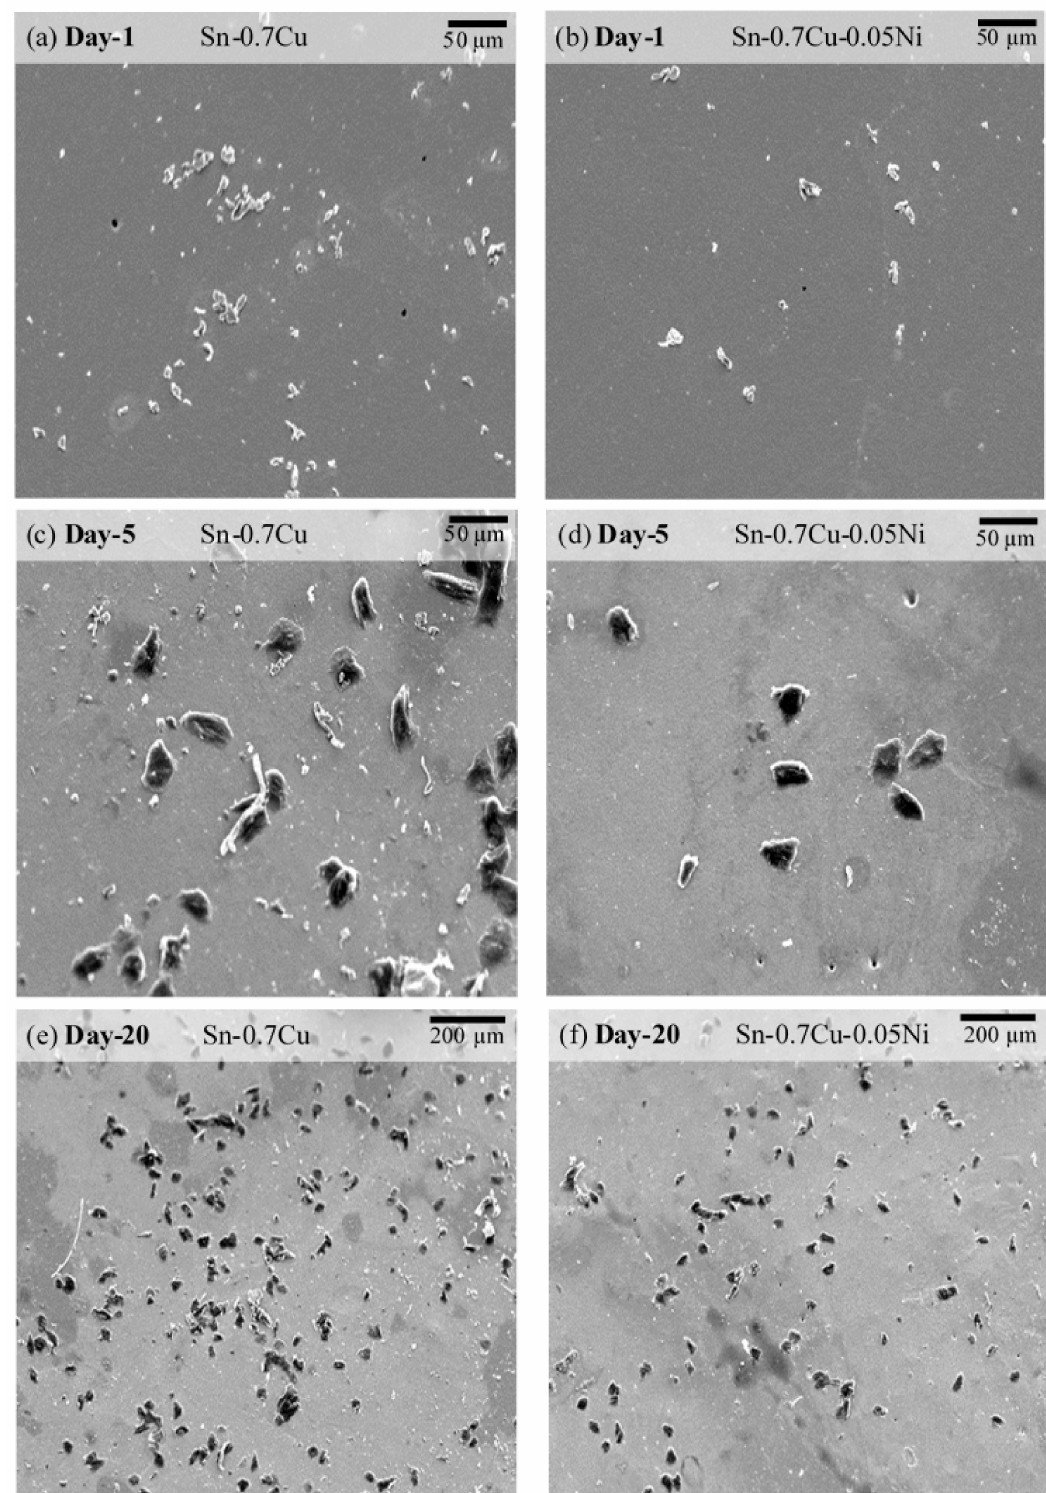
Figure 4. Surface morphologies of Sn whiskers’ distribution from Sn-0.7Cu and Sn-0.7Cu-0.05Ni solder coatings over a period of ( a , d ) 1 day, ( b , e ) 5 days and ( c , f ) 20